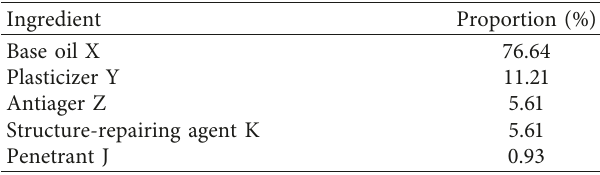
Table 1: Raw materials and dosages of